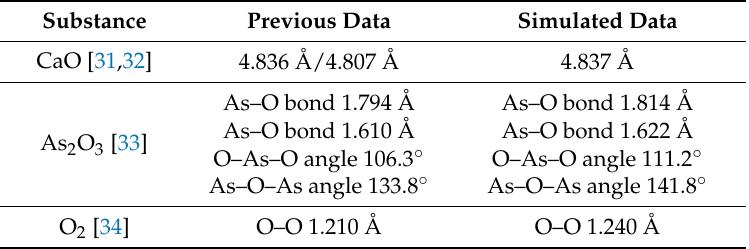
Table 1. Calculated lattice parameters, bond lengths, and bond